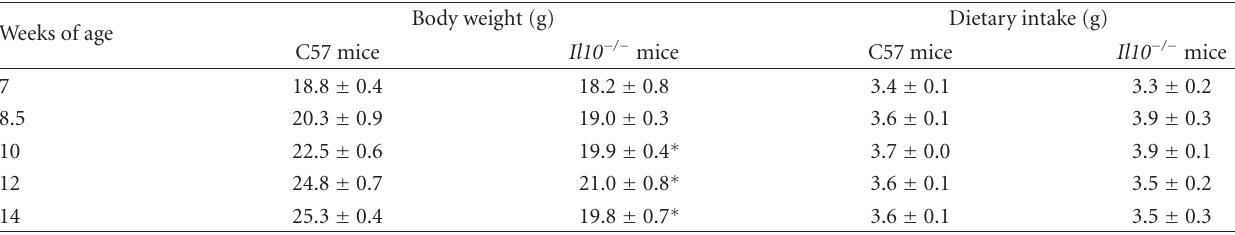
Table 1: Body weight and dietary intake of Il10 − / − and C57 mice at 7, 8.5, 10, 12, and 14 weeks of age. Weeks of